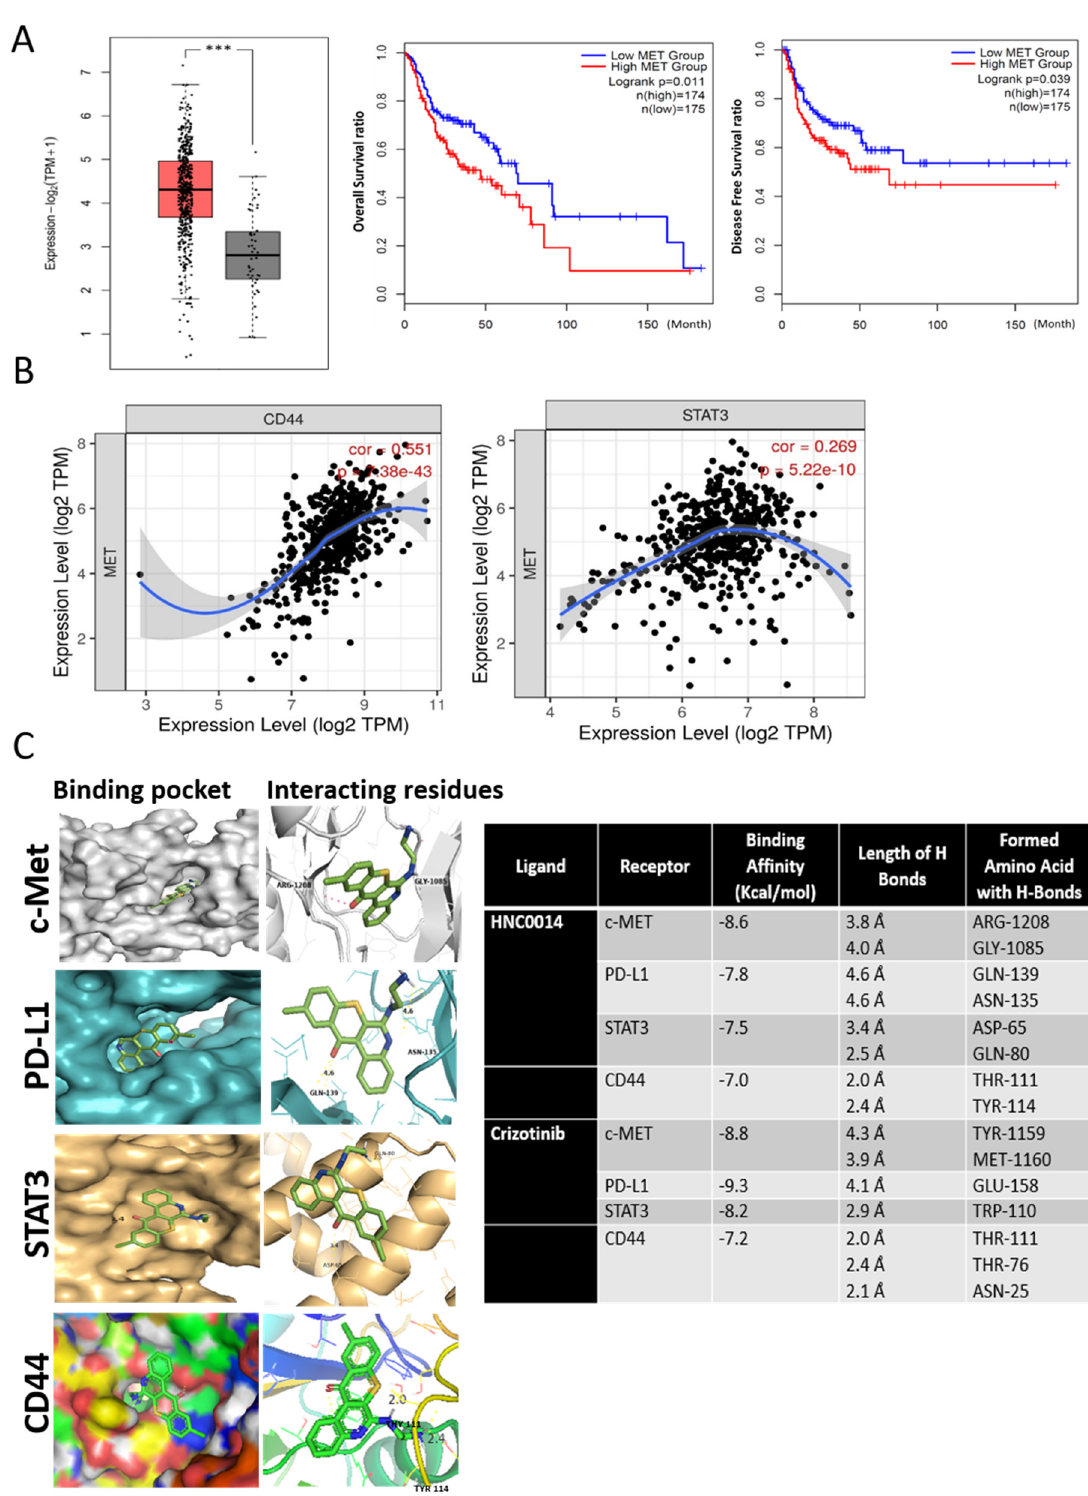
Figure 1. Elevated c-Met/STAT3/CD44 expressions in head and neck squamous cell carcinoma (HNSCC) patients were correlated with a poor prognosis. ( A ) A significantly higher c-Met expression level in patients with head and neck (red box, N = 519) compared to normal counterparts (grey box, N = 44). P = 1.0 × 10 -12 . Data analyses from The Cancer Genome Atlas (TCGA) and GTEx datasets (left). Kaplan–Meier plots of the overall survival (middle) and disease-free survival (right) ratios of HNSCC patients. *** p < 0.001. ( B ) Correlation analysis of the expression between c-Met and CD44 (left panel, r s = 0.551, p = 7.38 × 10 -43 ) and c-Met versus STAT3 (right panel, r s = 0.269, p = 5.22 × 10 -13 ).